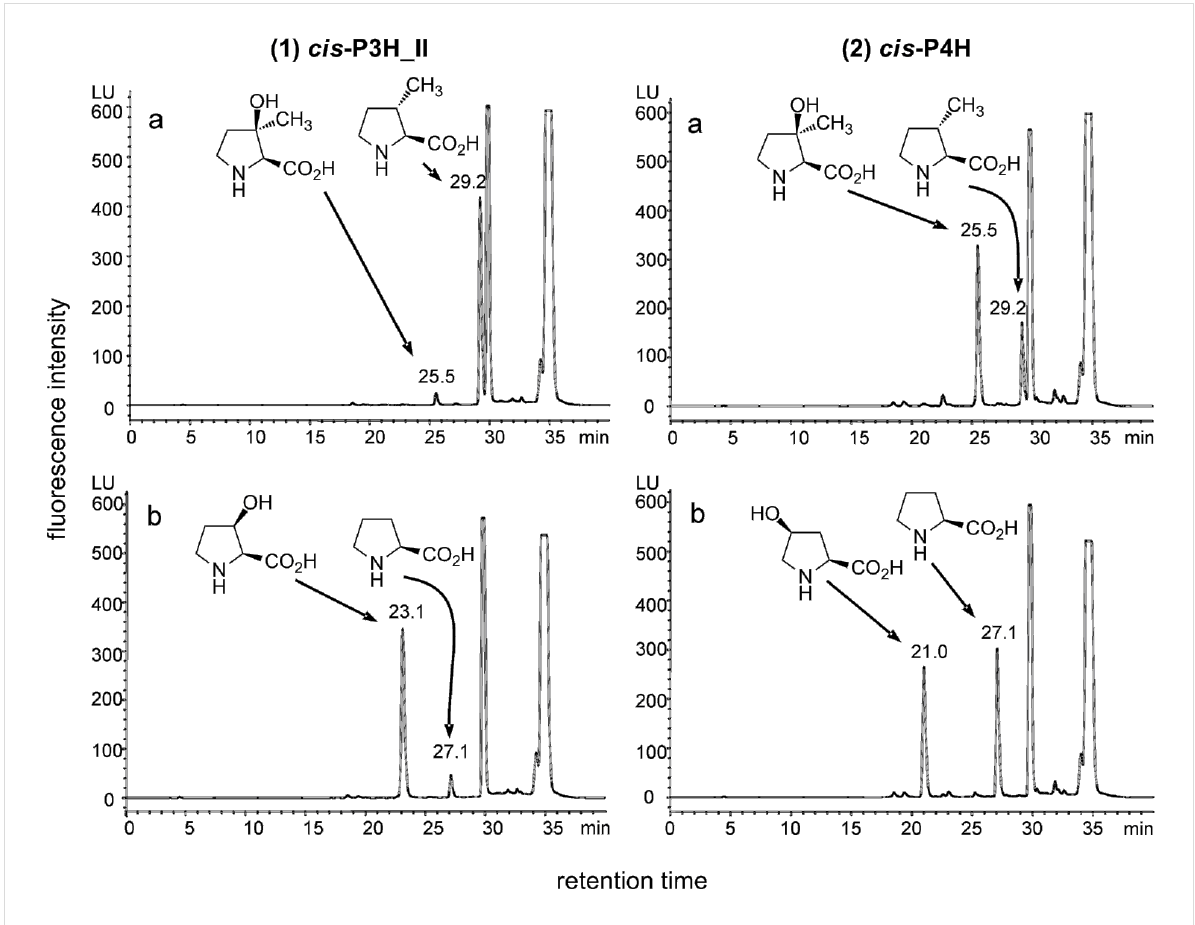
Figure 1: Typical HPLC-chromatograms of the conversions of (a) trans -3-methyl-L-proline and (b) L-proline under identical conditions with (1) cis - P3H_II and (2) cis -P4H. Yields are dependent on the amount of enzyme used. In this example the quantities are: (1)(a): 6.4% (0.25 mM); (1)(b): 90% (3.6 mM); (2)(a): 67% (2.7 mM); (2)(b): 50% (2.0 mM). The more significant relative yields in comparison to a reference reaction with L-proline are discussed in the text. Peaks at retention times >30 min are due to Fmoc-adducts formed during the derivatization reaction. Fluorescence assay wave- lengths: Excitation = 254 nm, emission = 316